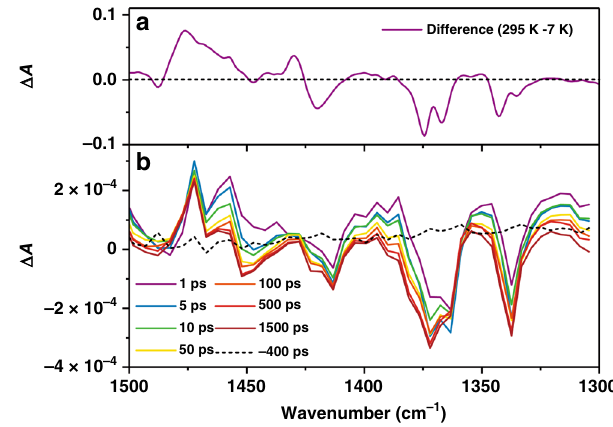
Fig. 5 Time-resolved transient IR difference spectra and the temperature-induced spectrum. a Temperature-induced IR difference spectrum between 295 K and 7 K; b picosecond timescale evolution of transient IR difference spectra with a 380-nm pump pulse at 190 K in the fi rst